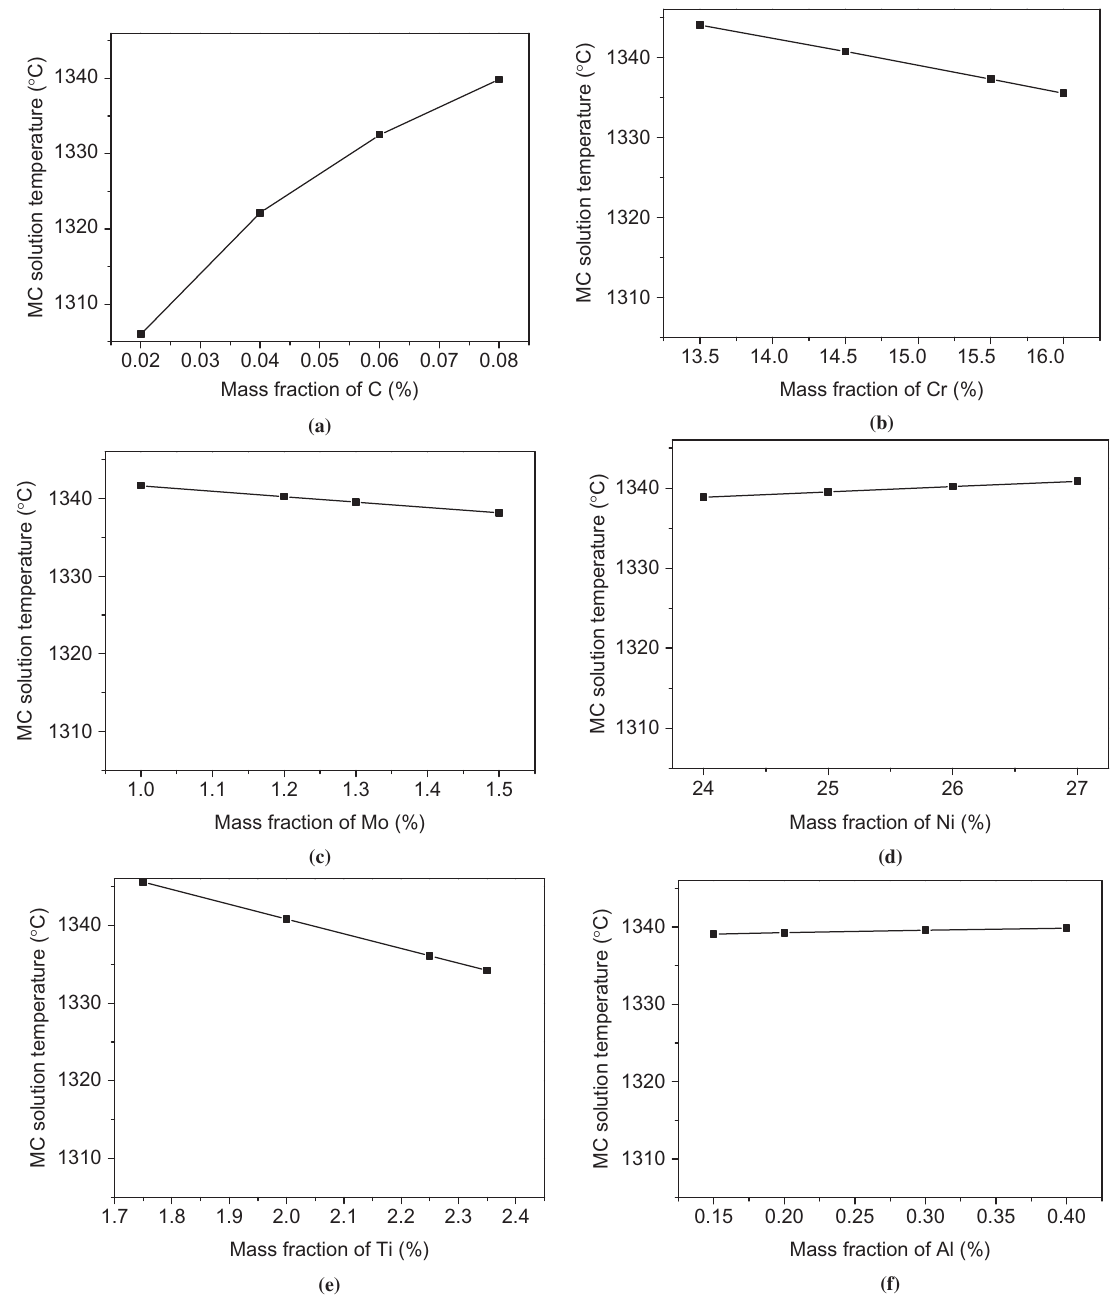
Figure 5: Variation of solution temperatures of MC phases with the contents of (a) C; (b) Cr; (c) Mo; (d) Ni; (e) Ti; (f)